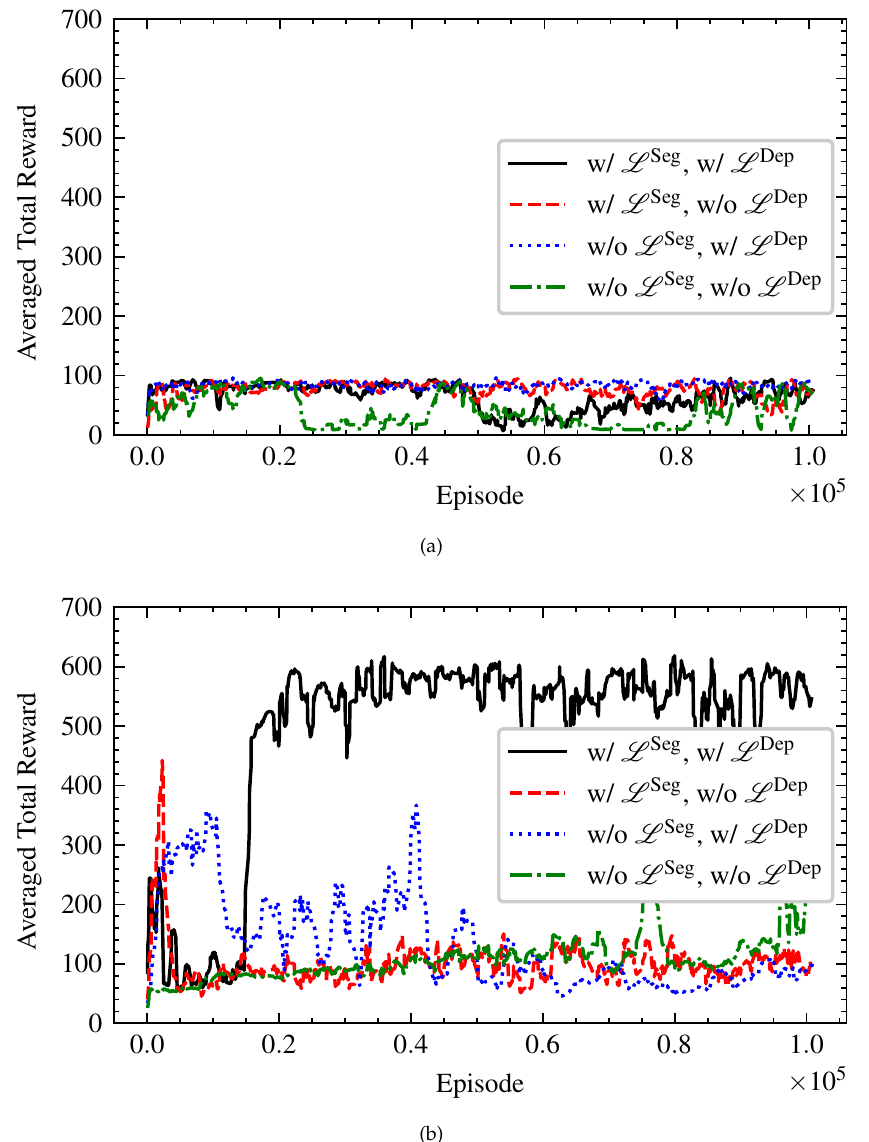
Figure 5. Comparison of the learning curves with different control frameworks and auxiliary losses. ( a ) Learning curve of the end-to-end active tracking controller with or without auxiliary losses. ( b ) Learning curve of the hierarchical active tracking controller with or without auxiliary